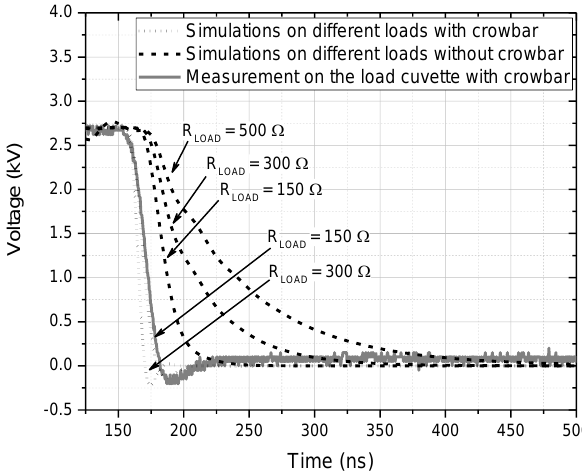
Figure 2. The comparison of pulse fall time with and without the crowbar circuit under different loads.